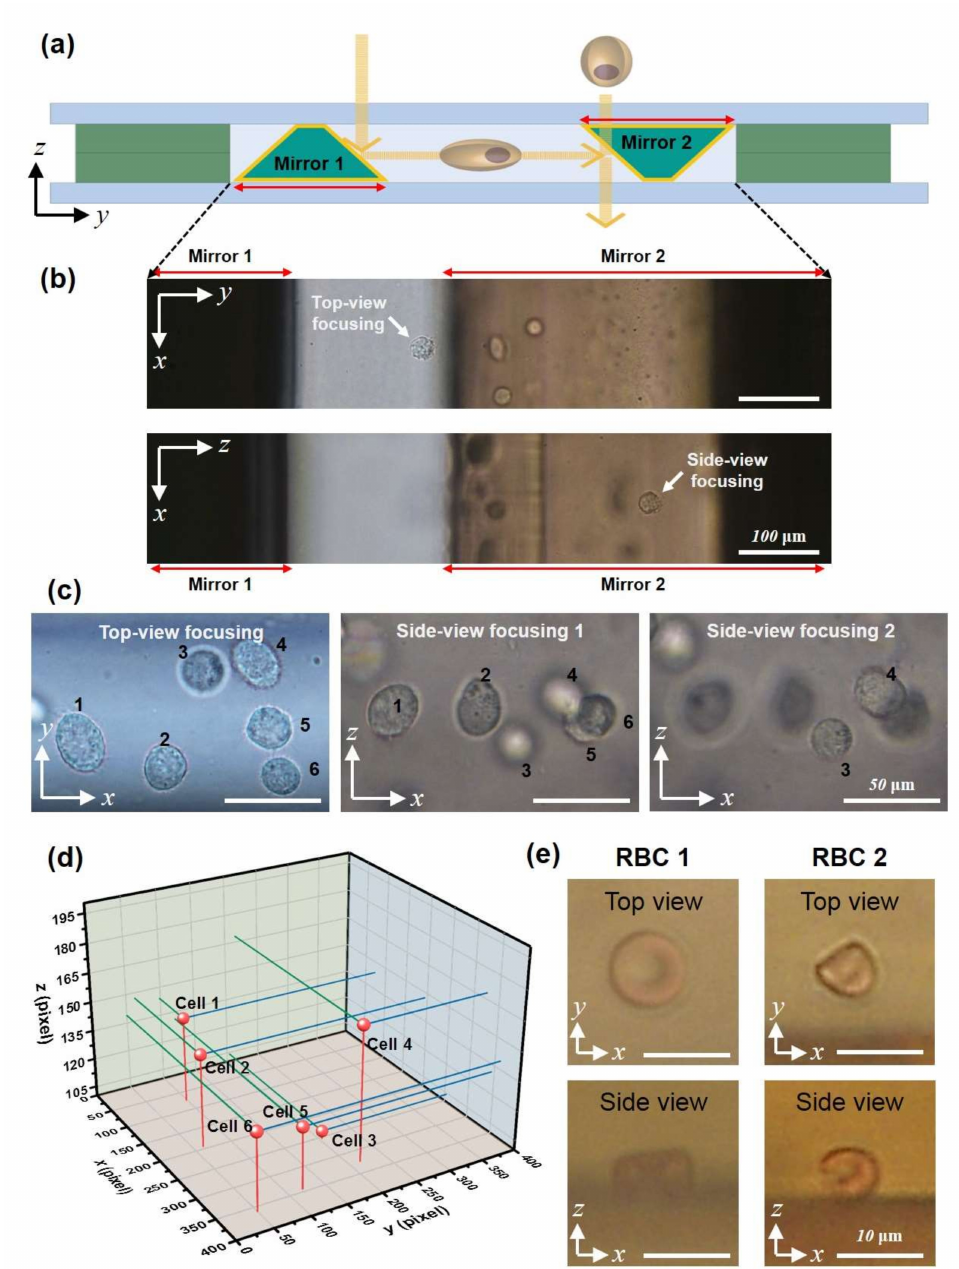
Figure 5. Quasi-3D imaging of live cells with a micromirror-embedded coverslip. ( a ) Schematic of bidirectional imaging. ( b ) Corresponding bright-field microscopy images of an H460 cell (with arrows, obtained with 20 × objective lens). The cell is located at di ff erent focal planes in the top-view and the side-view. ( c ) Image of multiple H460-GFP cells from top-view and two side-views with focusing at di ff erent depths. ( d ) 3D positions of the cells from c. ( e ) Bright-field images from the top-view and side-view of red blood cells (obtained with 50 × objective